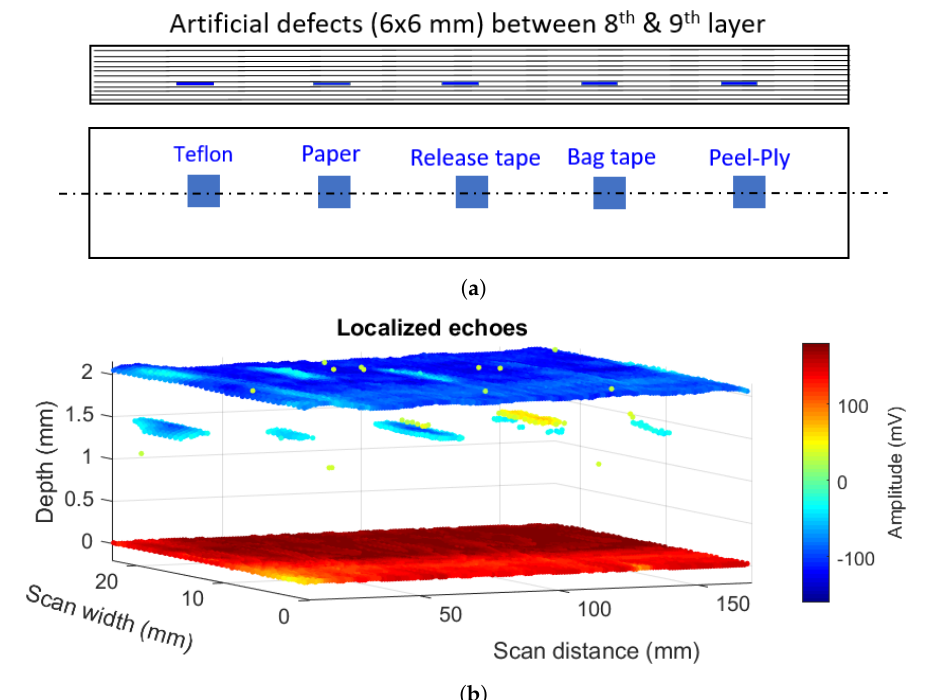
Figure 12. ( a ) Schematic of inserts (artificial defects) in the calibration sample and ( b ) 3D visualization of localized echoes using our modified algorithm and the smart thresholding.